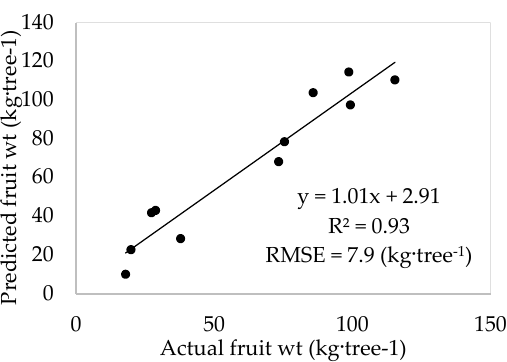
Figure 7. The correlation between actual and ANN model predicted total fruit weight (kg·tree −1 ) with combined VIs and TCA data for test set (n=11) in Orchard 1, Orchard 2 and Orchard 3. For total number of fruits, the scatter-plots between actual and ANN model predicted test set